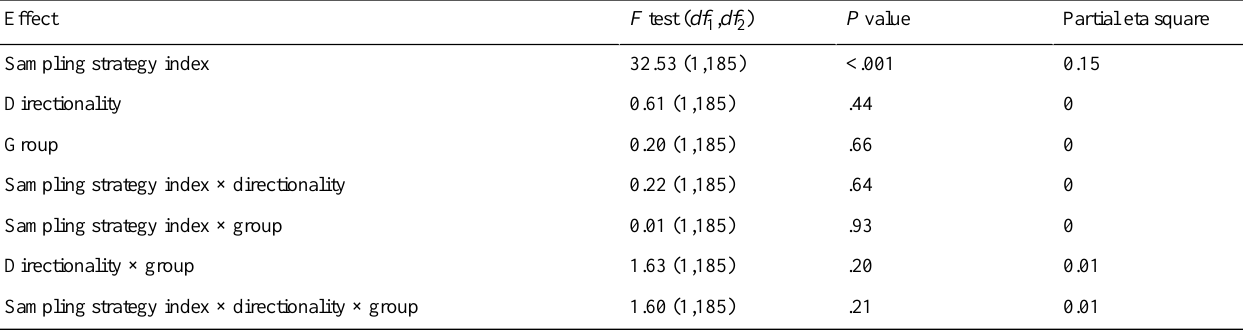
Table 1. Summary of ANCOVA analysis for variables predicting causal estimations.